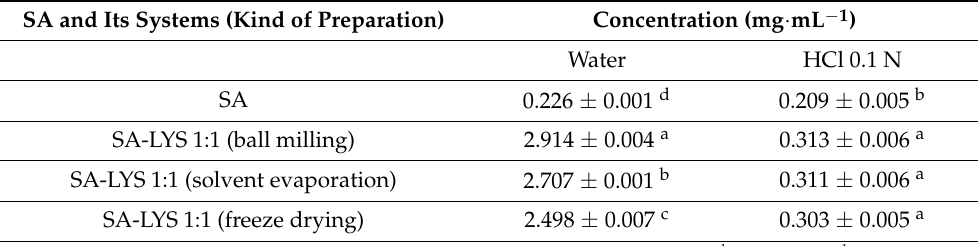
Table 2. The results of solubility studies of SA and SA co-amorphous systems with LYS in molar ratio